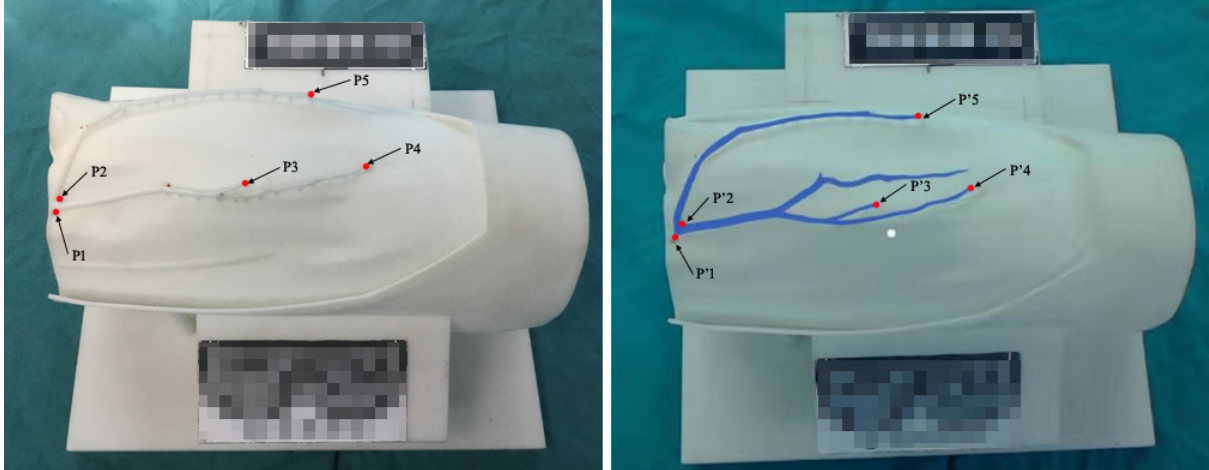
Figure 1. Three-dimensional printed model of the vascular map (A) and the augmented reality image with the virtual model of the vasculature overlapped onto the printed model (B). P1-P5, 5 points on the three-dimensional printed vascular map selected for precision analysis; P1’-P5’, 5 corresponding points on the virtual model.